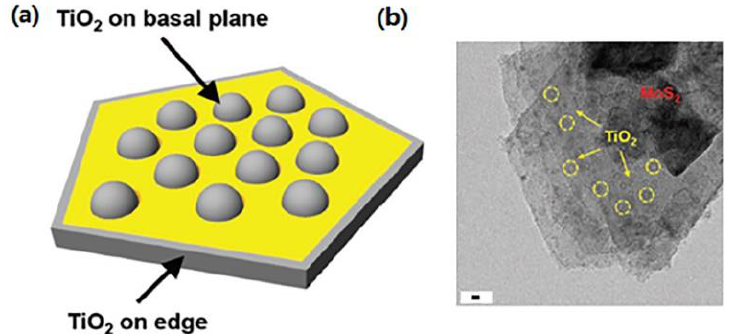
Figure 17. ( a ) Schematic illustration and ( b ) TEM image of the ALD TiO 2 coating on pristine MoS 2 . Reprinted with permission from [126]. Copyright 2017,